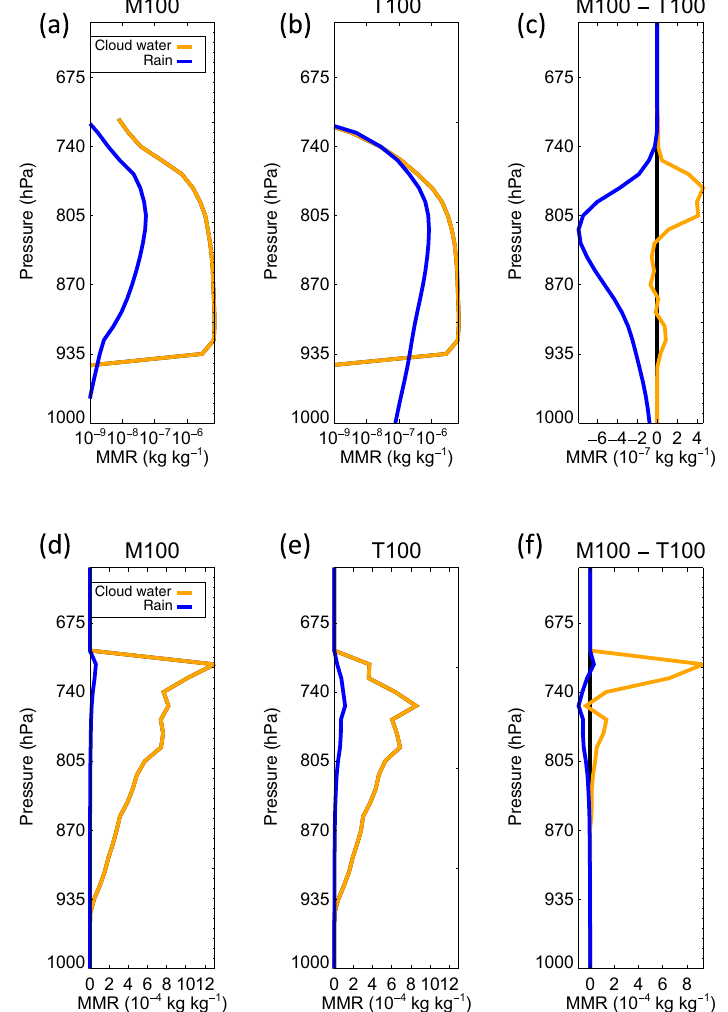
Figure 11. RICO case: mean vertical profiles of hydrometeor mass mixing ratios (MMRs), as in Fig. 6, averaged over the 24h of the RICO simulation. (a) RICO-M100 cloudy column domain mean, (b) RICO-T100 domain mean, (c) RICO-M100 domain mean minus RICO- T100 domain mean, (d) RICO-M100 condensate mean over each hydrometeor class, (e) RICO-T100 condensate mean and (f) RICO-M100 condensate mean minus RICO-T100 condensate mean. Note that because the rain amounts are very small, especially in M100, panels (a, b) are shown with a logarithmic horizontal